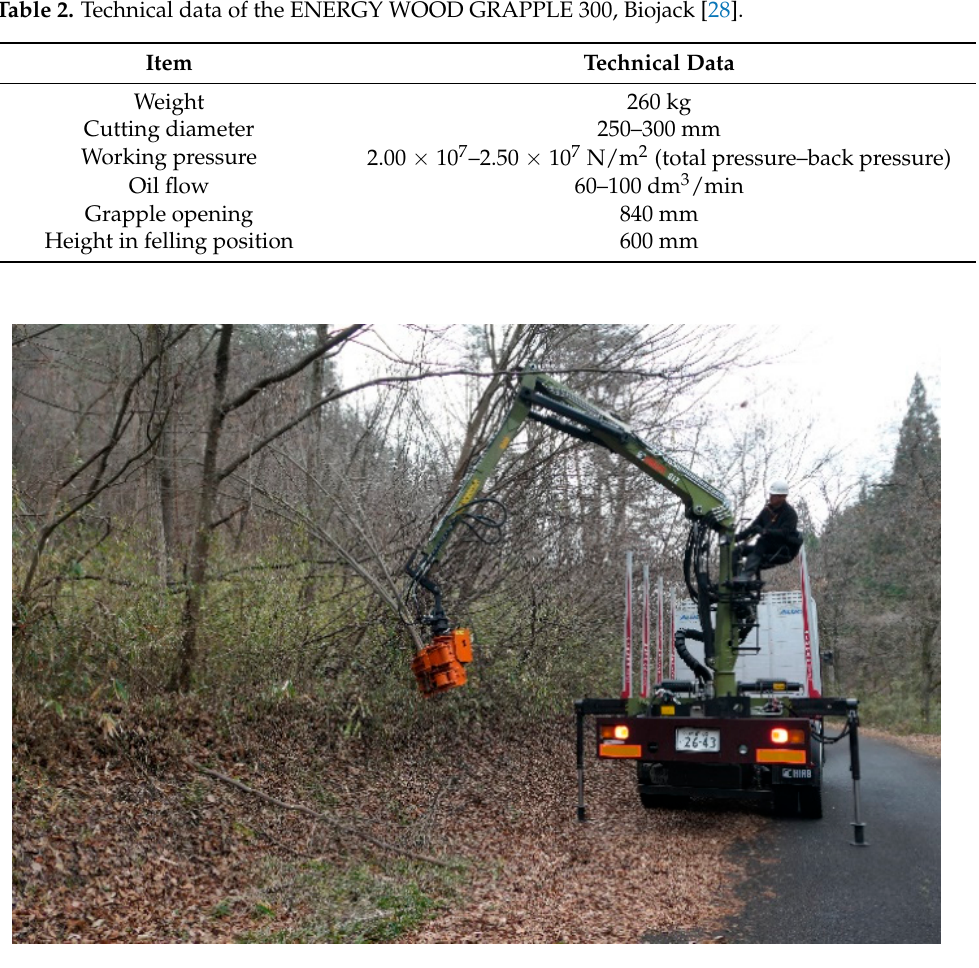
Figure 4. Harvesting experiment with a truck-mounted multi-tree felling